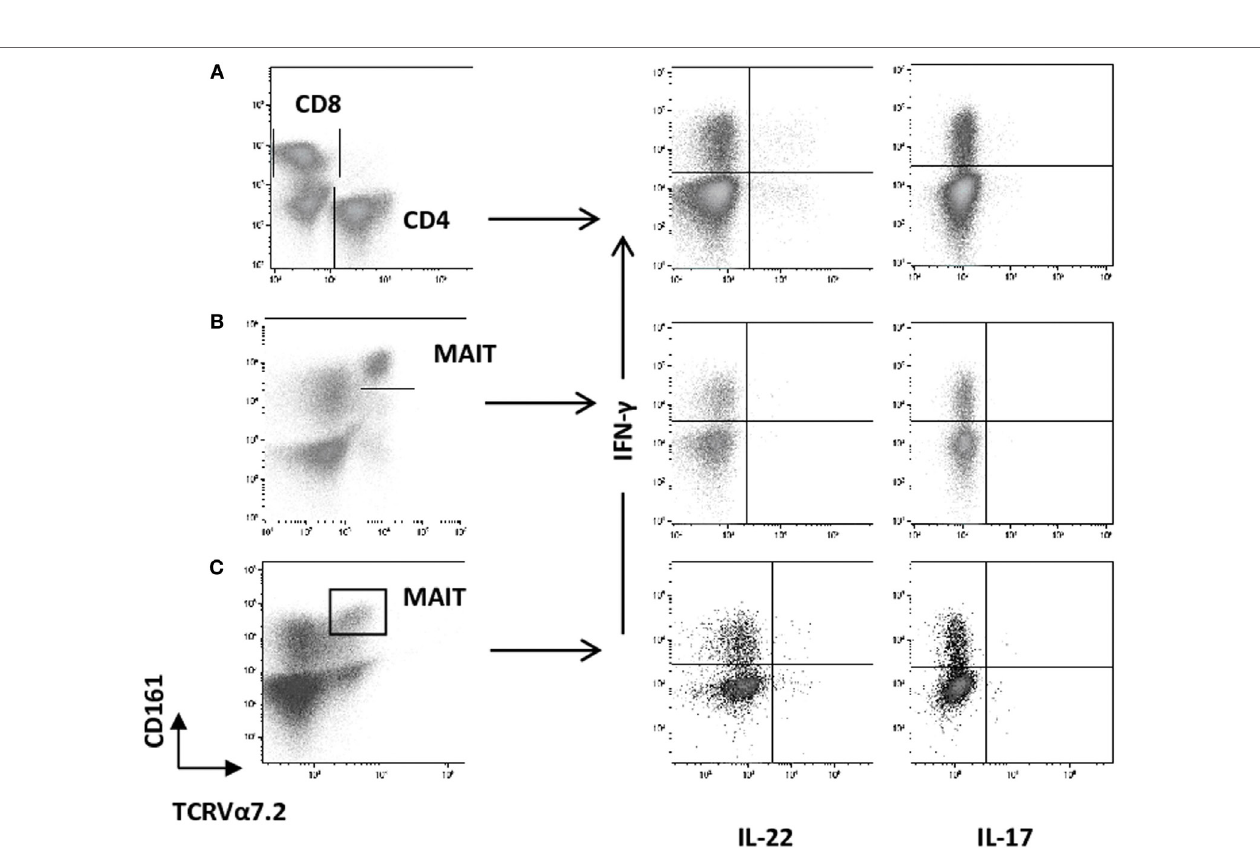
FigUre 1 | Analysis of blood γδ T cells and mucosal-associated invariant T (MAIT) cells in patients with ankylosing spondylitis (AS) and in healthy controls (HC). (a) Representative dot plots showing the gating strategy used to identify conventional CD4 + and CD8 + T cells, MAIT, and γδ T cells in peripheral blood mononuclear cell by flow cytometry. CD3 + T cells were gated on total lymphocytes (FSC/SSC plot after doublet exclusion), then MAIT cells were identified as TCRV α 7.2 CD161 high among CD3 + T cells. TCR γδ + T cells were identified among CD3 + T cells. Of note, MAIT cells are included in the CD8 + T cell population (see Table 2 for explanations). (B) AS patients showed a significant lower number of circulating γδ T cells than HC. Circulating γδ T cells were analyzed as described in Section “Patients and Methods” and gated as described in (a) . Absolute numbers (cells/mm 3 ) were obtained by multiplying the percentages of γδ T cells by the total T lymphocyte number. Each symbol represents an AS patient (squares, n = 34) or HC (circles, n = 25). (c) AS patients showed a significant lower number of circulating MAIT cells than HC. Circulating MAIT cells were analyzed as described in Section “Patients and Methods” and gated as described in (a) . Absolute numbers (cells/mm 3 ) were obtained by multiplying the percentages of MAIT cells by the total T lymphocyte number. Data are depicted as box plots (the band inside the box corresponds to the median). Each symbol represents an AS patient (squares, n = 18) or HC (circles, n =